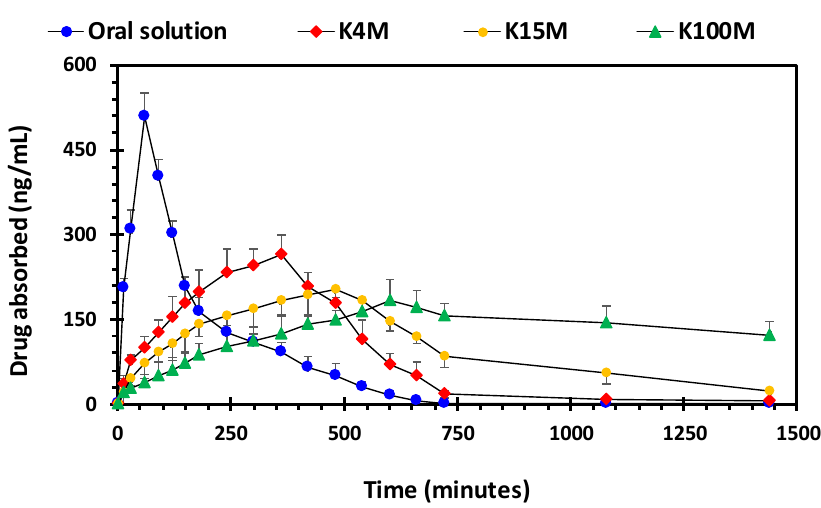
Figure 10. Overall matrix erosion vs, time profile of 3D printed HPMC matrix tablets.